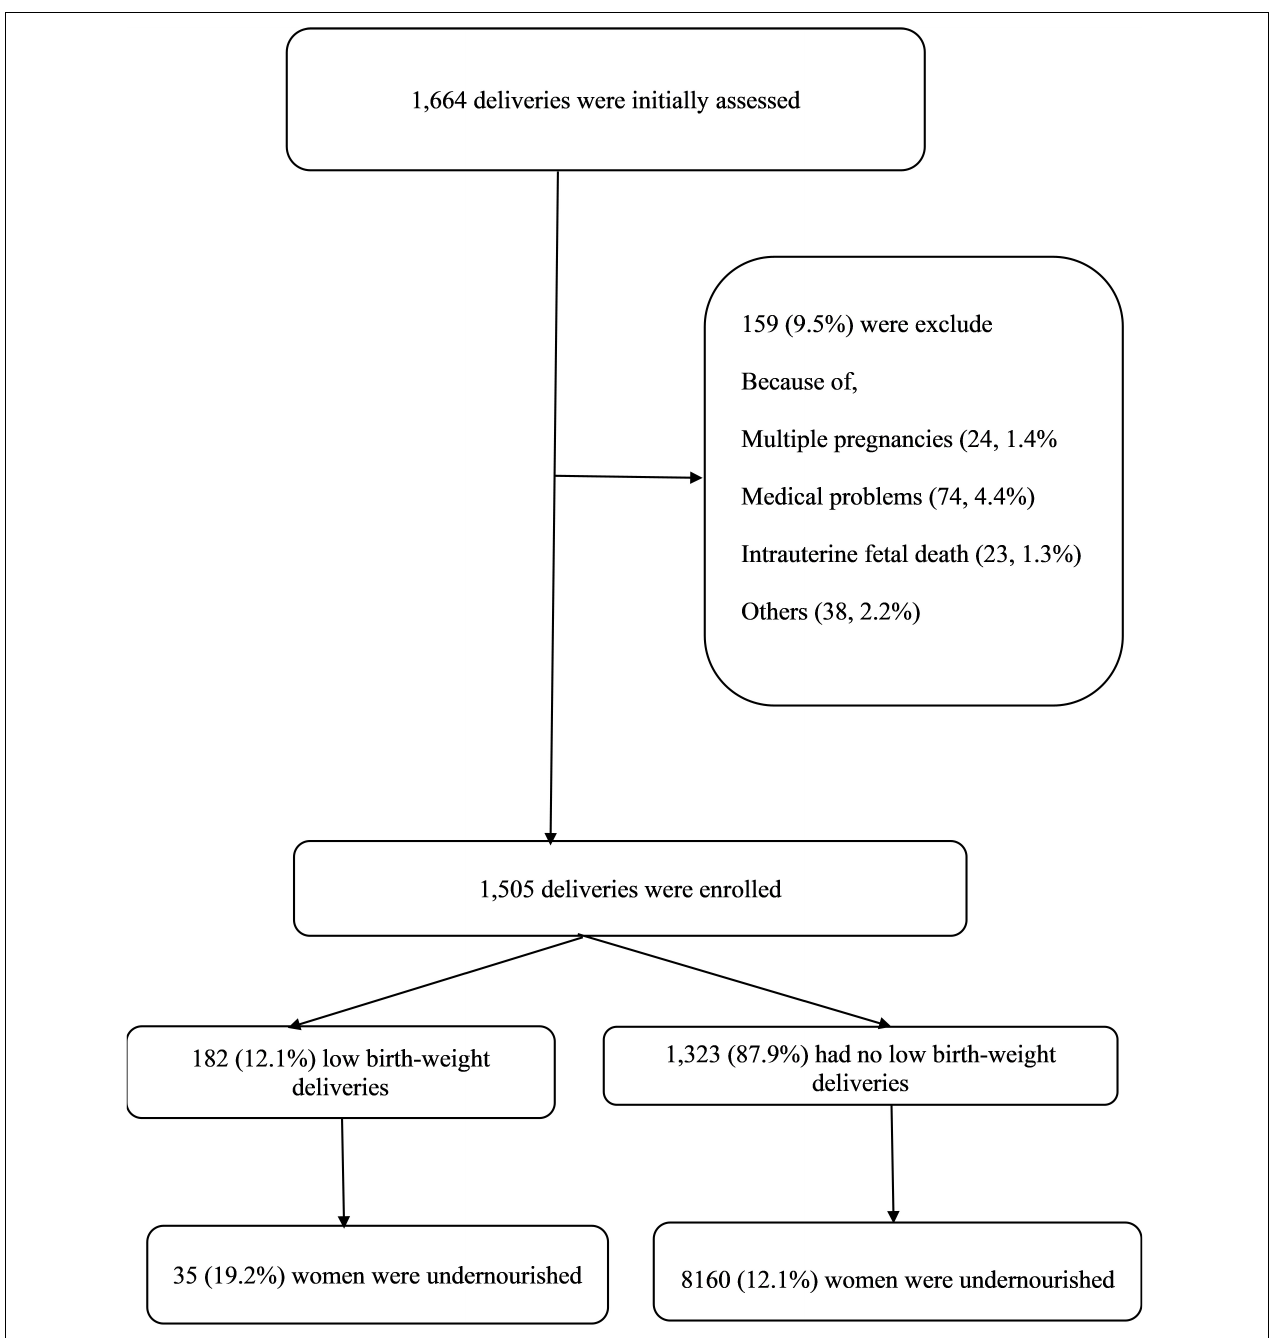
FIGURE 1 | The flow chart for the